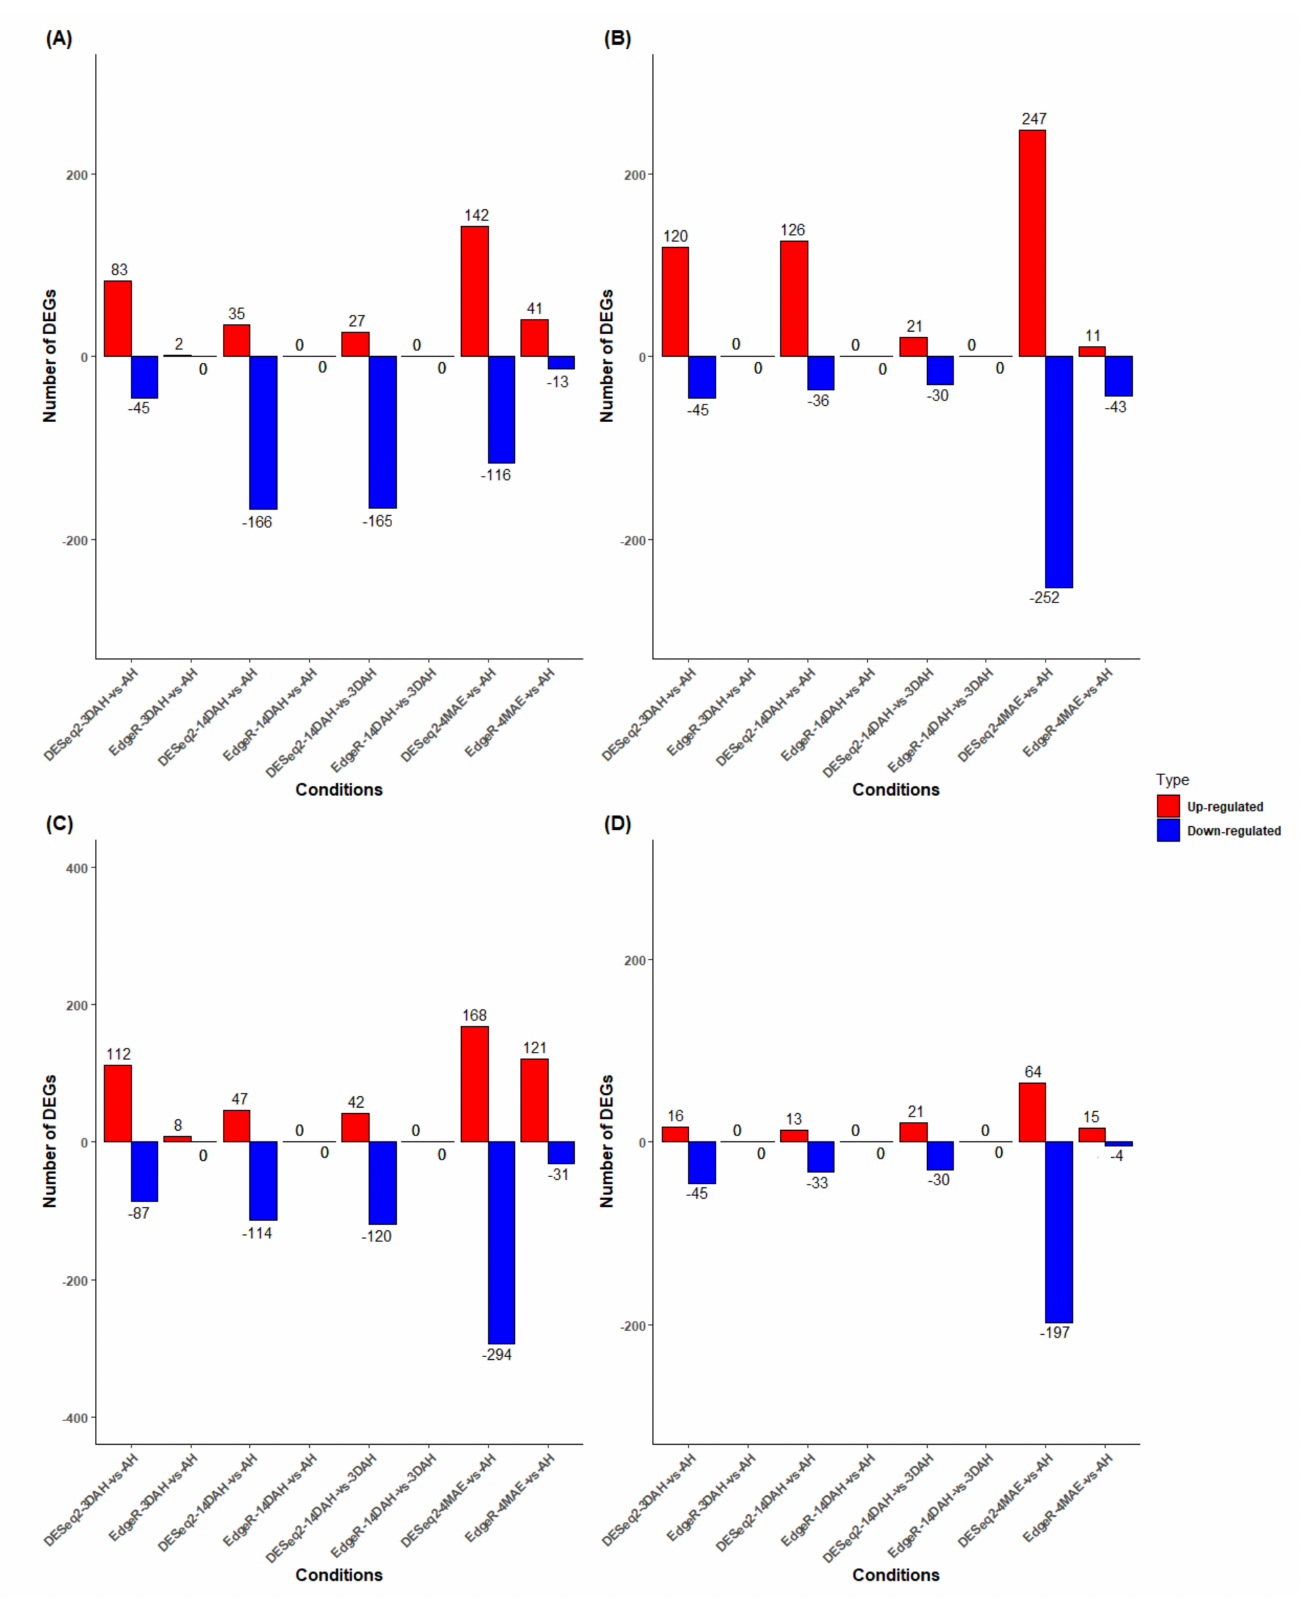
Figure 2. The number of differentially expressed genes (DEGs) based on the comparison of DESeq2 and EdgeR 4MAE and after harvest (AH, 3DAH, and 14DAH). ( A ) Bangou 1, ( B ) Bayangam 2, ( C ) Fonkouankem 1, ( D ) Ibo sweet 3 (non-hardening accession). Blue represents down-regulated transcripts and red represents up-regulated